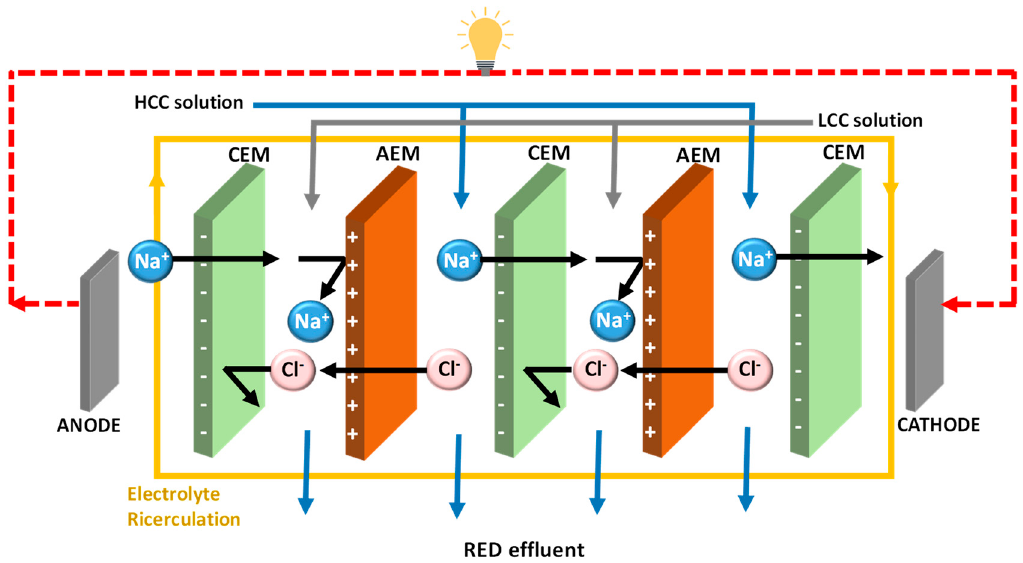
Figure 1. Schematic illustration of reverse electrodialysis (RED) for salinity gradient power generation. The high concentration compartment (HCC) and low concentration compartment (LCC) are created by a series of alternative cation exchange membranes (CEMs) and anion exchange membranes (AEMs). The electrical energy is generated by the redox reactions occurring over the two electrodes placed at the ends of the membrane pile.